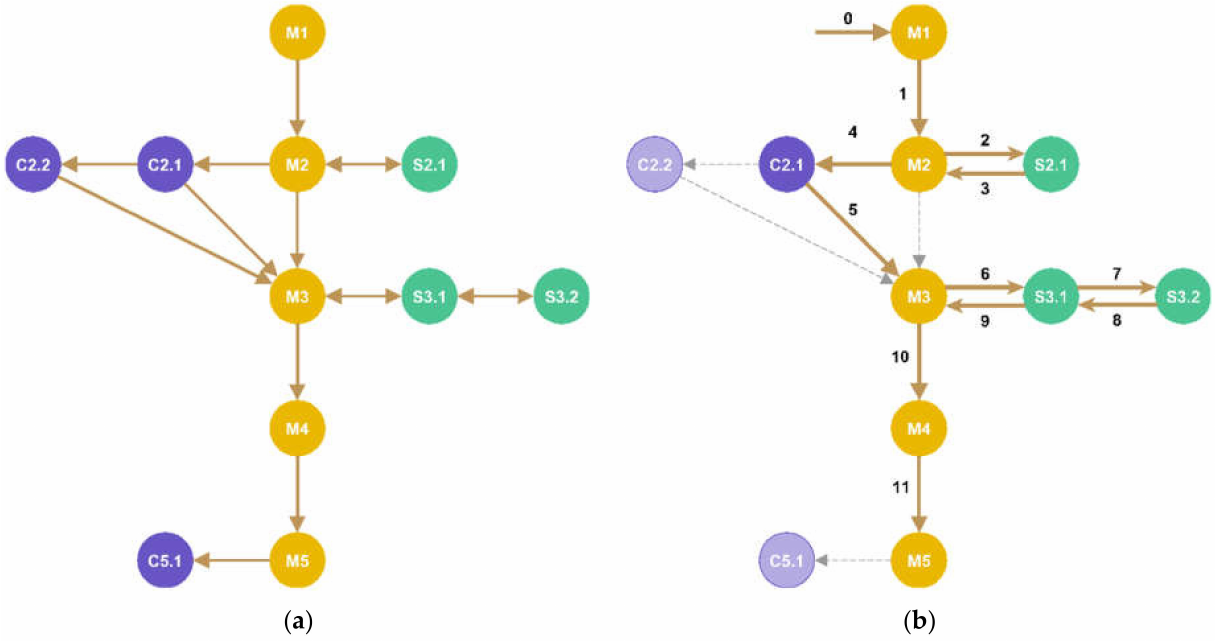
Figure 5. Learning graph and learning path: ( a ) The given learning graph, and ( b ) a learning path as one possible way to work on this learning